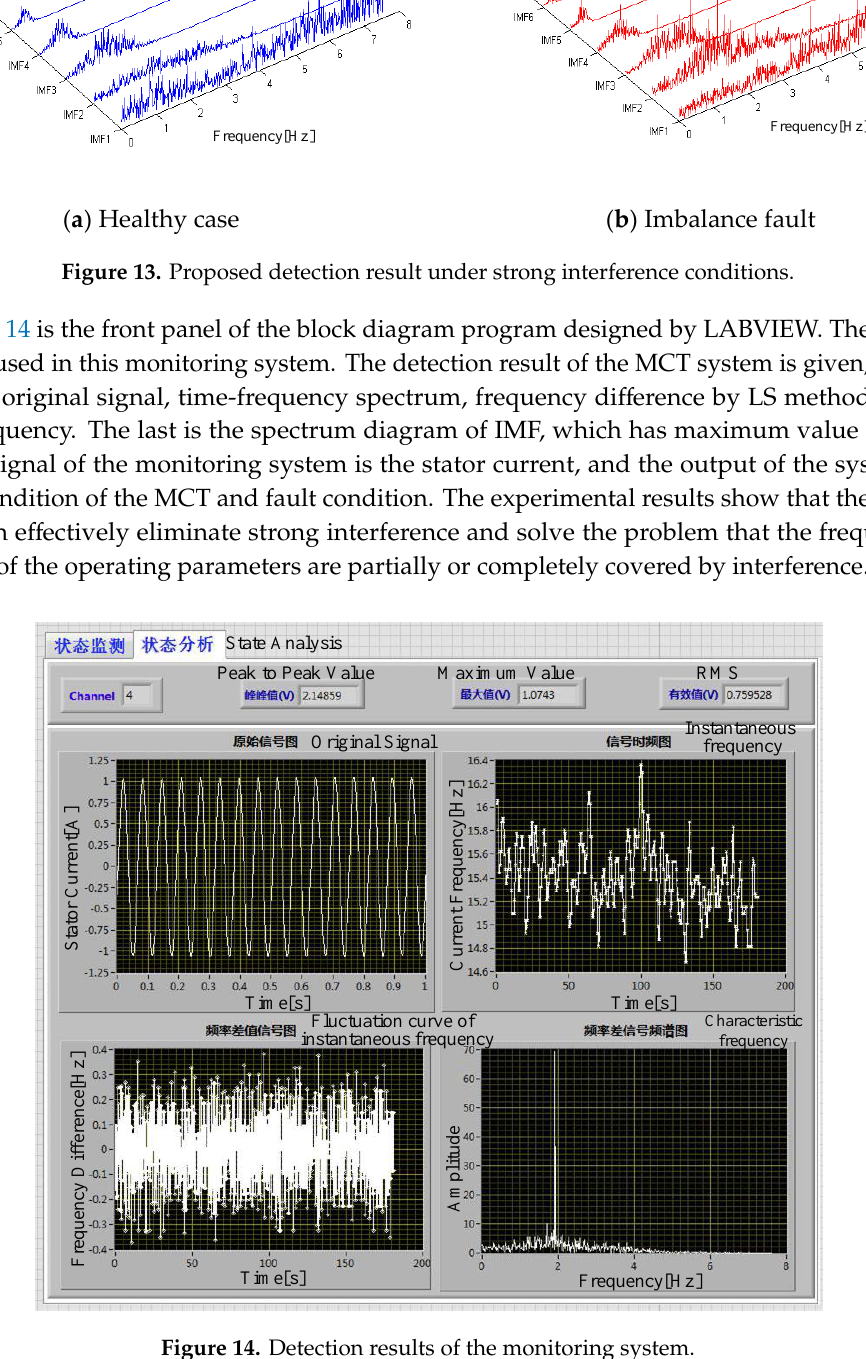
Figure 14. Detection results of the monitoring system.